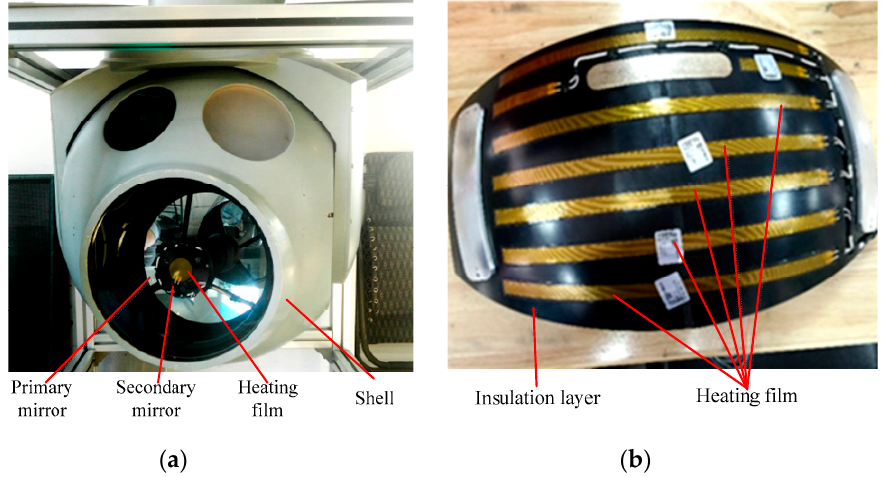
Figure 6. Schematic of the active thermal measure. ( a ) Heating films on the optical systems; ( b ) heating films on the insulation layer.